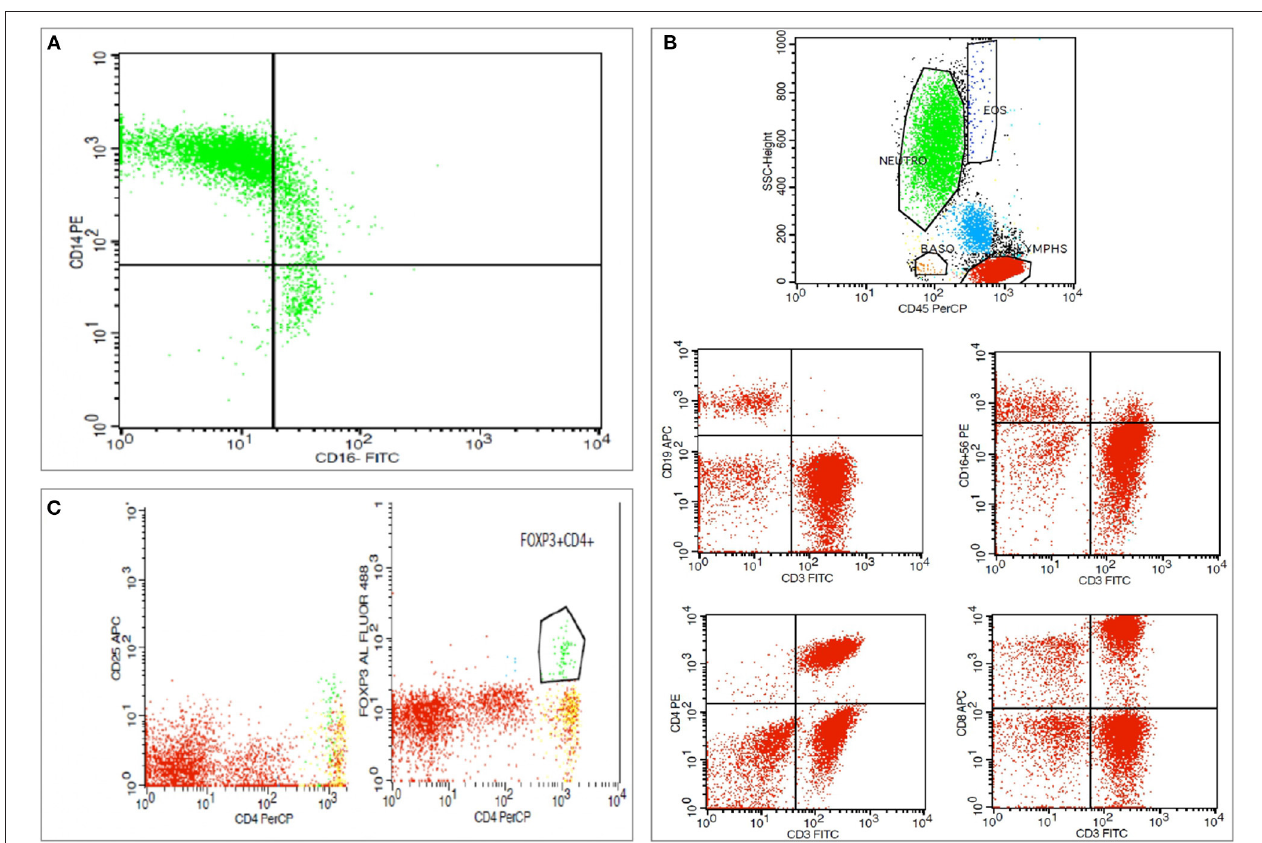
FIGURE 2 | Flow cytometric analysis of a peritoneal dialysis patient. (A) Representative dot plots depicting monocyte subsets, differentiated according to their surface expression pattern of CD14 and CD16 in CD14 ++ CD16–, CD14 ++ C16 + and CD14 + CD16 + subpopulations. (B) Representative dot plots depicting lymphocyte gating with B-lymphocytes, and T lymphocytes, natural killer (NK) cells defined as CD16 + CD56 + cells, CD4 + T cells, CD8 + T cells. (C) Representative dot plots depicting regulatory T cells (Tregs) defined as CD4 + FoxP3 + CD25 high positive